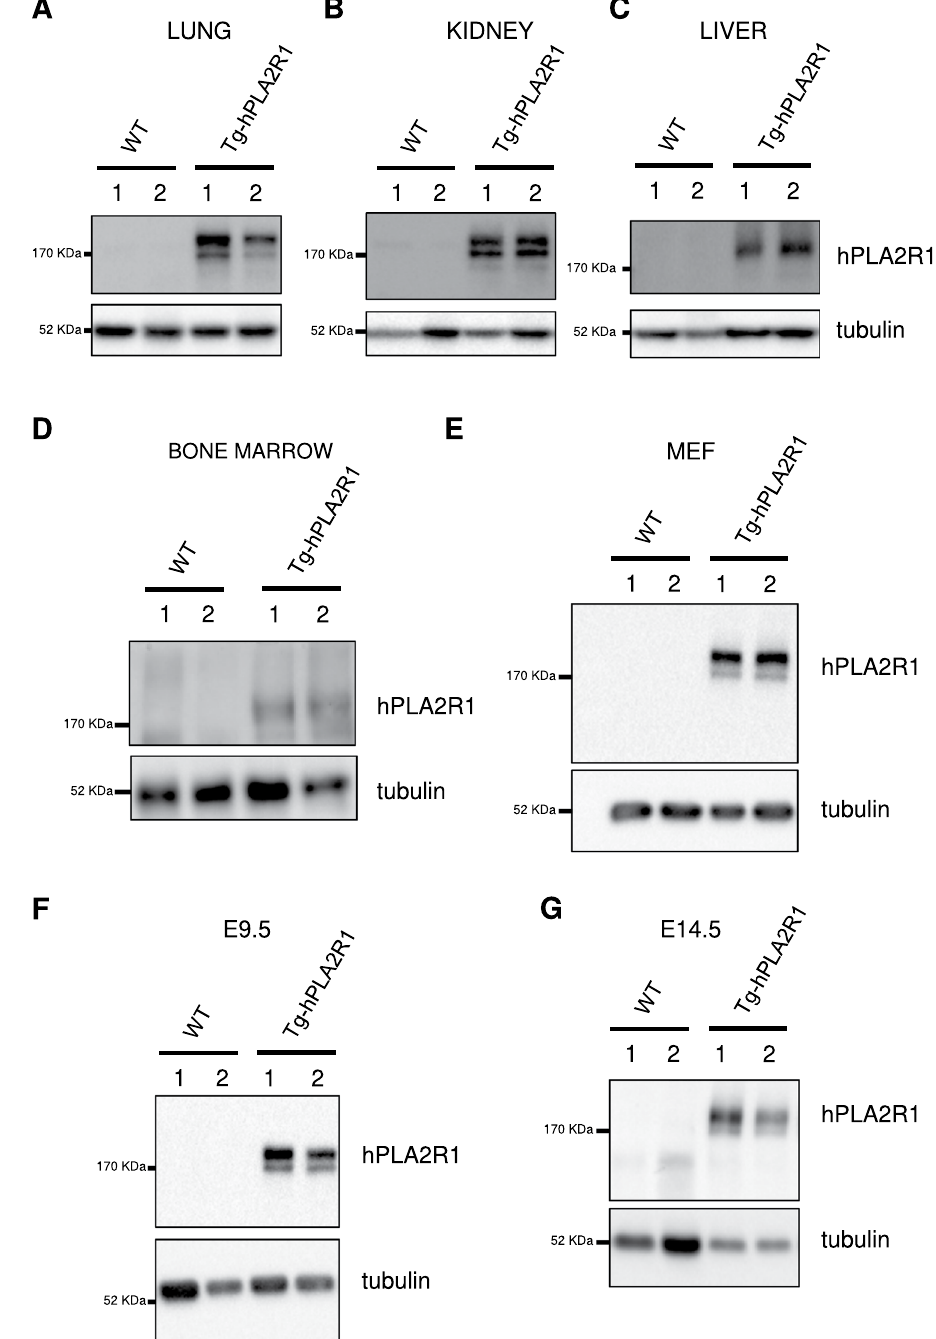
Figure 3. Expression of the hPLA2R1 protein in adult tissues, embryos and MEFs. ( A – D ) Protein lysates of lung ( A ), kidney ( B ), liver ( C ) and bone marrow ( D ) were prepared from 6 months old mice and analyzed by Western-blot using anti-PLA2R1 and anti-tubulin antibodies. ( E – G ) Expression of hPLA2R1 protein in E13.5- dpc derived MEFs ( E ), E9.5dpc whole embryo ( F ) and E14.5dpc fetal-liver ( G ) are shown. Immunoblots are represented for 2 WT and 2 Tg-hPLA2R1 littermate samples (indicated as 1 and 2) in all